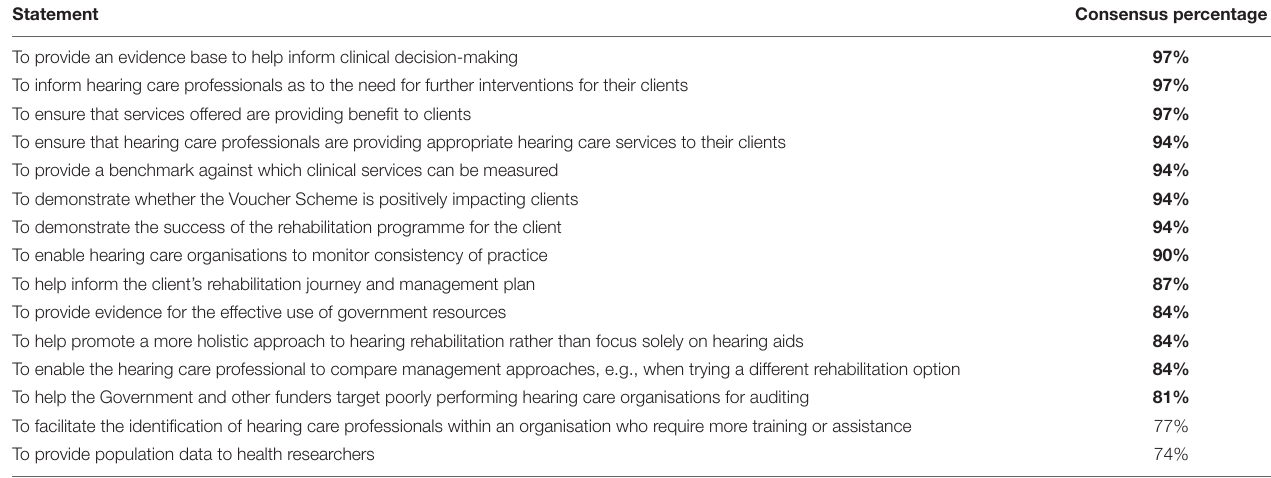
TABLE 8 | Statements from the reasons for collection section among the professional group.